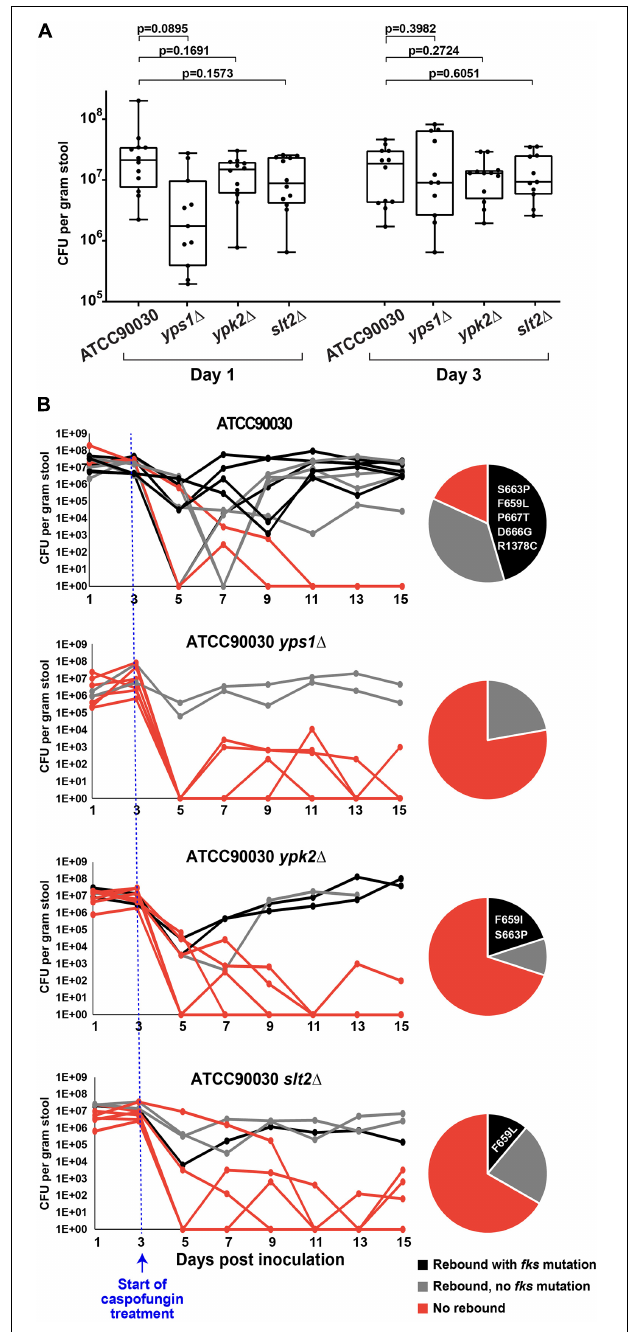
FIGURE 4 | Three cell wall integrity mutants ( yps1 (cid:49) , ypk2 (cid:49) , and slt2 (cid:49) ) exhibited reduced caspofungin tolerance and decreased emergence of strains with reduced susceptibility to caspofungin in the mouse model of GI colonization. (A) Prior to the start of caspofungin treatment, all mice reached and maintained a fungal burden of 10 6 –10 8 CFU/g of stool, with non-significant differences between groups. (B) Caspofungin treatment was more effective at sterilizing the GI of mice colonized with the cell wall integrity mutants. Mice colonized with the ATCC90030 parental strain showed a higher rebound of fungal burden relative to the deletion mutants, which was due to strains both with and without fks mutations. All obtained mutations were in the FKS2 gene, and the specific amino acid changes are listed in the pie